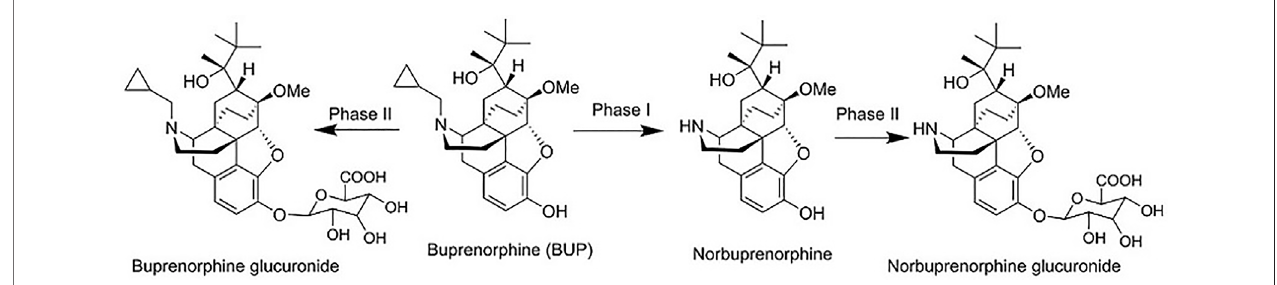
FIGURE2| Themain metabolism pathway and metabolites ofBUP, including norbuprenorphine,norbuprenorphineglucuronide,and buprenorphine glucuronide.